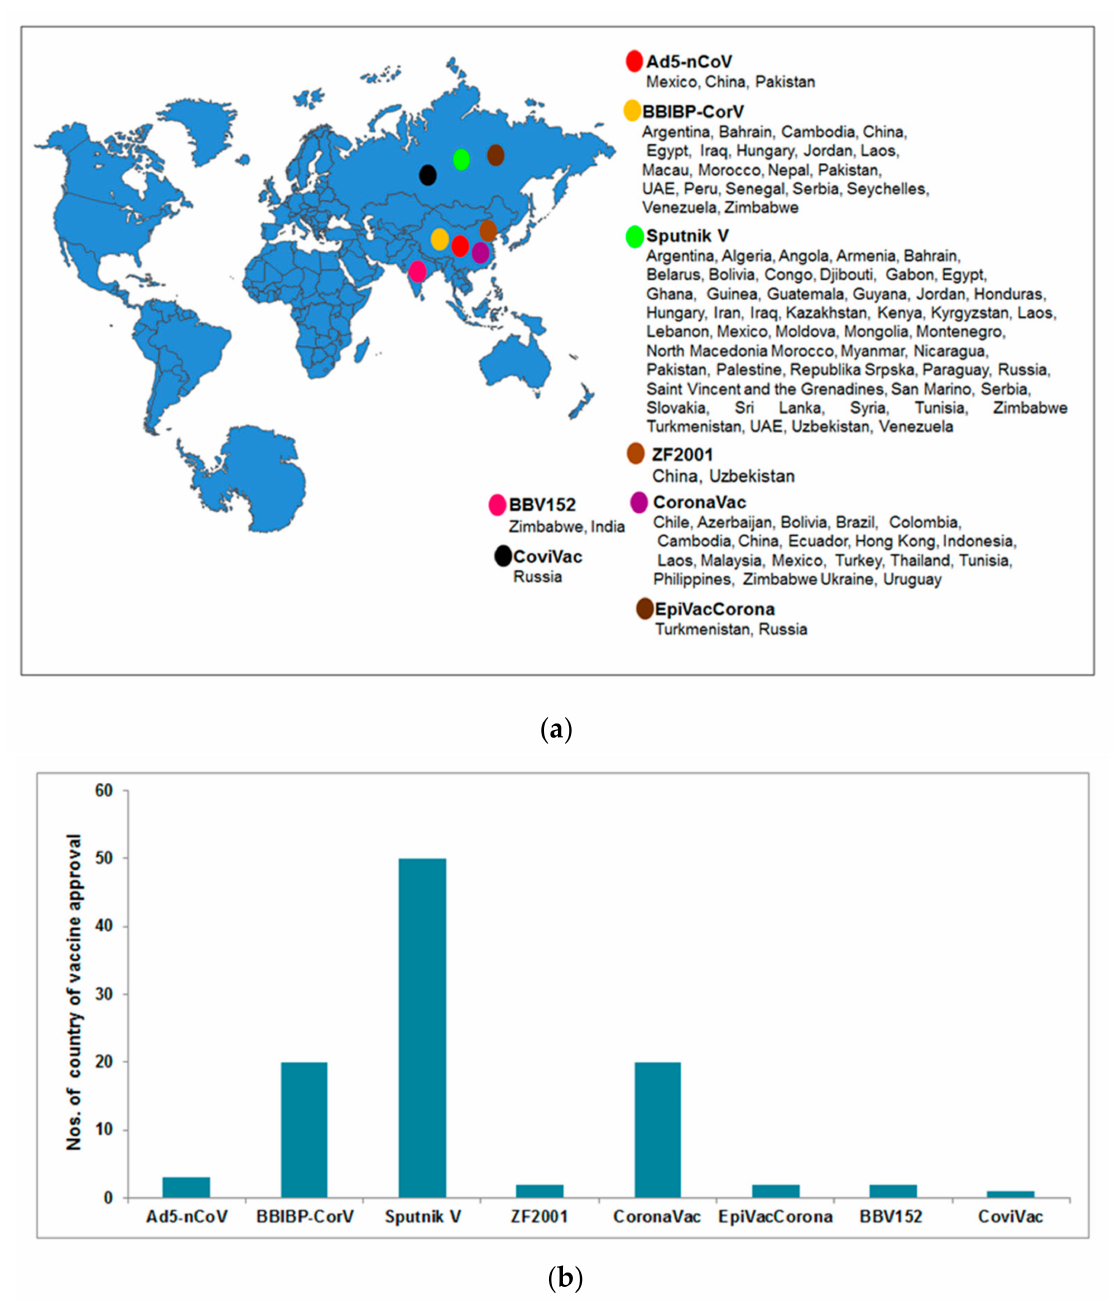
Figure 5. Regulatory approval of Asian-origin COVID-19 approved vaccines. ( a ) Asian-origin COVID-19 vaccines and their approval countries. ( b ) Asian-origin COVID-19 vaccines and number of approval countries. (Data source: Vaccine Tracker, Statista, COVID-NMA, ClinicalTrials.gov,